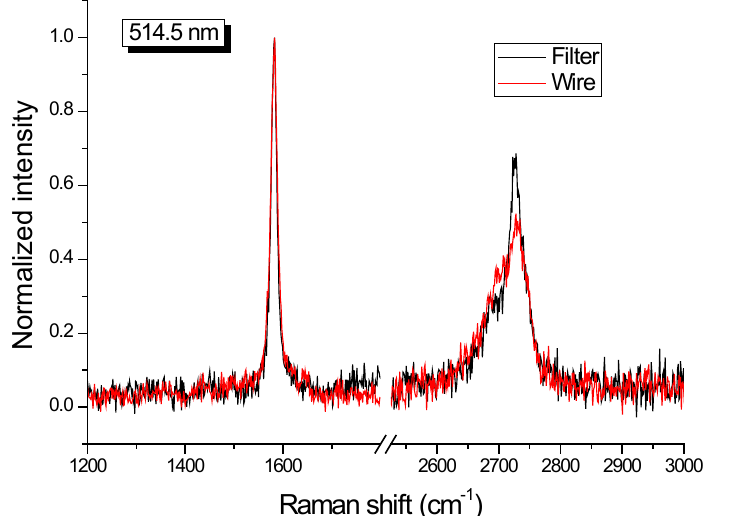
Figure 4. Normalized Raman spectra on the copper wire and filter.